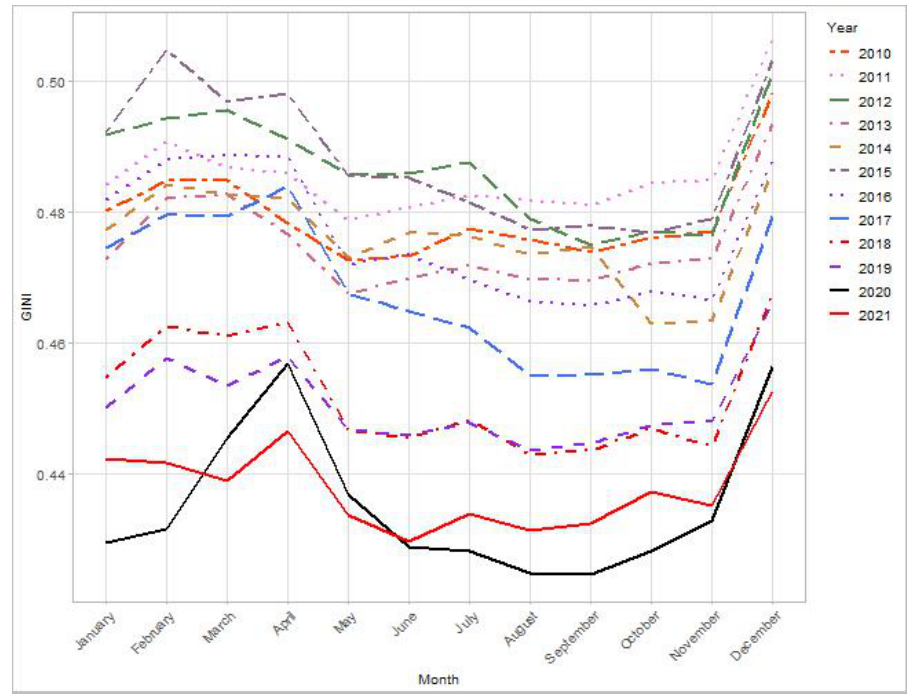
Figure 1. Gini index: males, age group